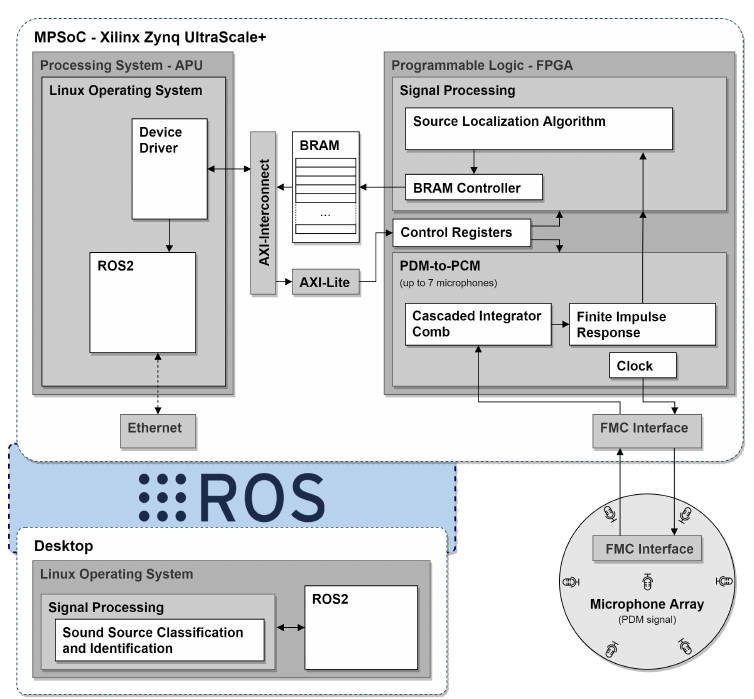
Figure 1. Sensor system